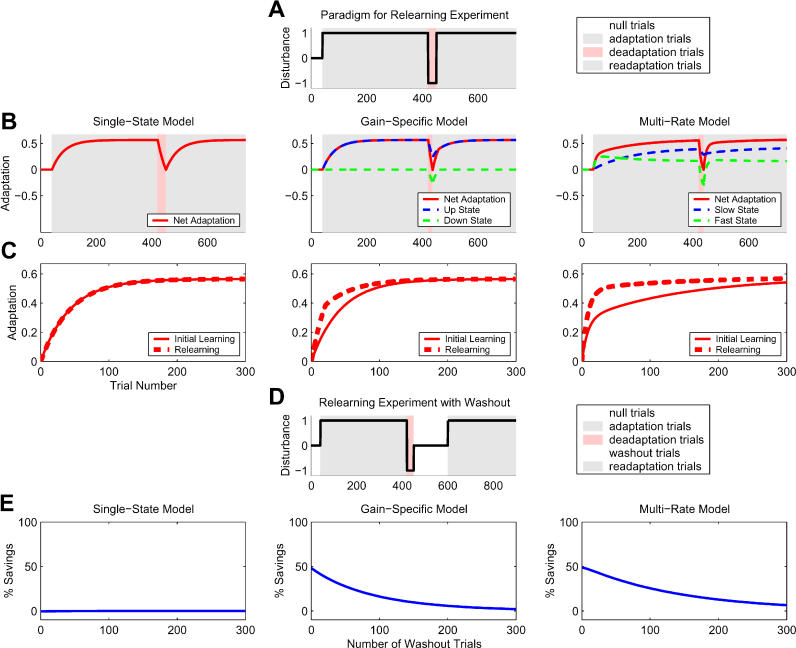
Simulations of Motor Adaptation Experiments That Show Savings(A) Paradigm for basic savings experiment. This paradigm consists of four blocks: (1) a baseline period, (2) initial learning, (3) unlearning, and (4) relearning. Note that adaptation stimulus for the unlearning block is opposite that used in learning blocks, and the number of trials in the unlearning block is adjusted so that on this block's last trial performance is at the baseline level.(B and C) Model simulations of the experiment paradigm shown in (A). The first row (B) shows the raw results of these simulations, while the second row (C) shows a direct comparison of simulated performance in the initial learning and relearning blocks. The different columns display simulation results from the single-state, gain-specific, and multi-rate models, respectively. The single-state model fails to show savings (faster relearning), but the gain-specific and multi-rate models show savings.(D) Paradigm for savings experiment with washout. Note that this paradigm is similar to the paradigm shown in (A), except that a washout block of variable length is inserted prior to the relearning block.(E) The amount of savings found in simulation, as a function of the number of washout trials. The amount of savings is measured as the percent improvement in performance on the 30th trial in the relearning block compared to the 30th trial in the initial learning block. The columns are the same as in (B). The gain-specific and multi-rate models show similar washout of savings; however, in the single-state model there is no savings to wash out.